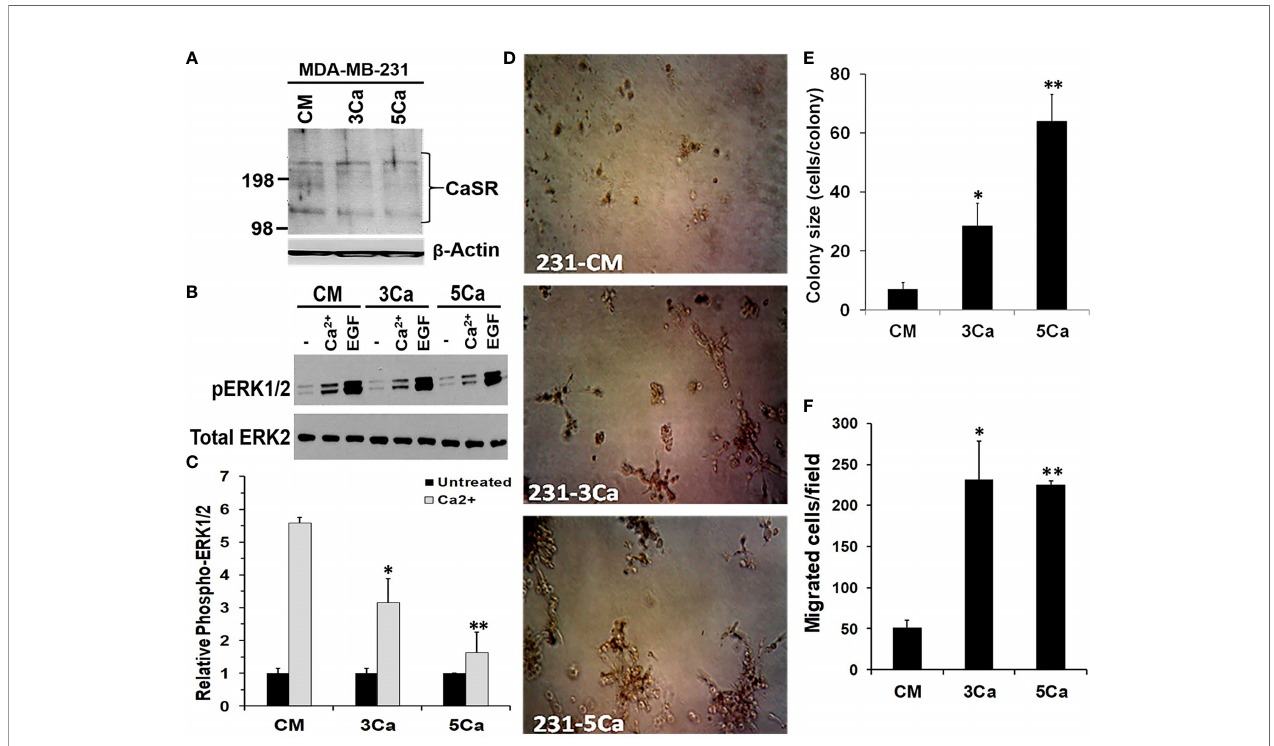
FIGURE 2 | High calcium adaptation of breast cancer cells is associated with reduced sensitivity of CaSR to extracellular Ca 2+ but promotes cell growth and motility. (A) MDA-MB-231 cells were cultured in complete medium supplemented with 3.0 or 5.0 mM Ca 2+ for up to 6 weeks. The expression of CaSR in the Ca 2+ adapted cells was assessed by western blotting; b -actin was used as the loading control. (B) The Control, 3.0 and 5.0 mM Ca 2+ adapted MDA-MB-231 cells were treated with EGF (50 ng/ml) or high Ca 2+ (5.0 mM) for 10 mins and the activation of ERK1/2 assessed by western blotting. (C) The protein bands representing phosphorylated ERK1/2 were quanti fi ed by using the NIH ImageJ. Bares represent active ERK1/2 relative to untreated control from independent experiments. (D, E) Control, 3.0 and 5.0 mM Ca 2+ adapted MDA-MB-231 cells were seeded at 1000 cells/well in 96 well plates on growth factor reduced Matrigel and cultured in complete medium for up to 10 days. Cell colonies were captured microscopically using a digital camera (D) and colony sizes were assessed by manually counting the cells in each colony (E) . (F) Migration of Ca 2+ adapted cells. Control, 3.0 and 5.0 mM Ca 2+ adapted MDA-MB-231 cells in serum free medium were cultured for 24 h in Boyden chamber inserts and serum free medium containing 5.0 mM Ca 2+ was used as the chemoattractant. Shown are the migrated cells/ fi eld from at least three independent fi elds. * denotes p < 0.05, ** denotes p <